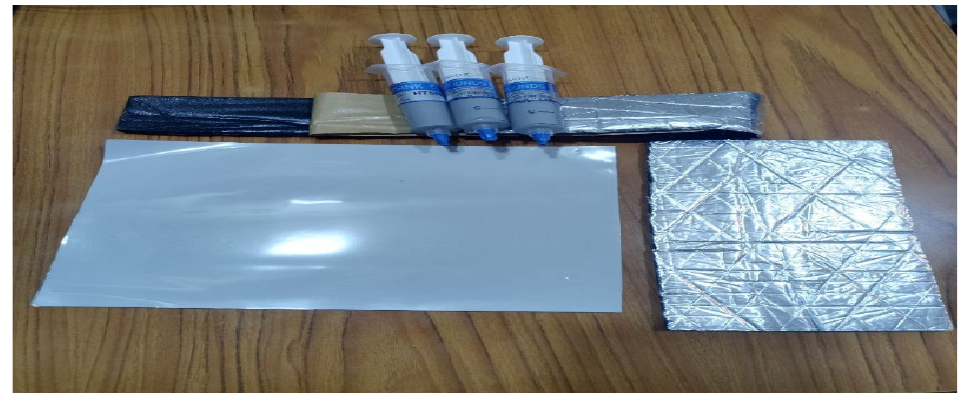
Figure 7. Thermal paste, arrays and insulators used in the panel.